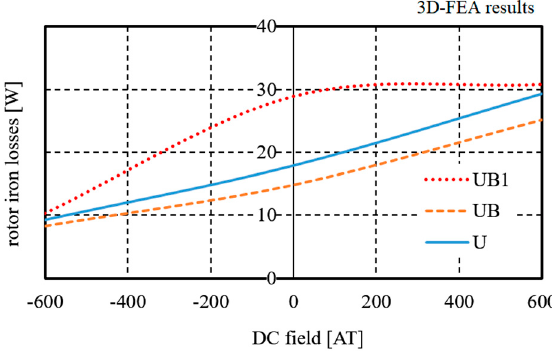
Figure 10. Mean values of rotor iron losses of UB1, UB, and U rotor concepts. Table 2. Iron losses calculation coefficient values of the Bertotti method for M400-50A lamination. Considered Quantities for Sheet Iron